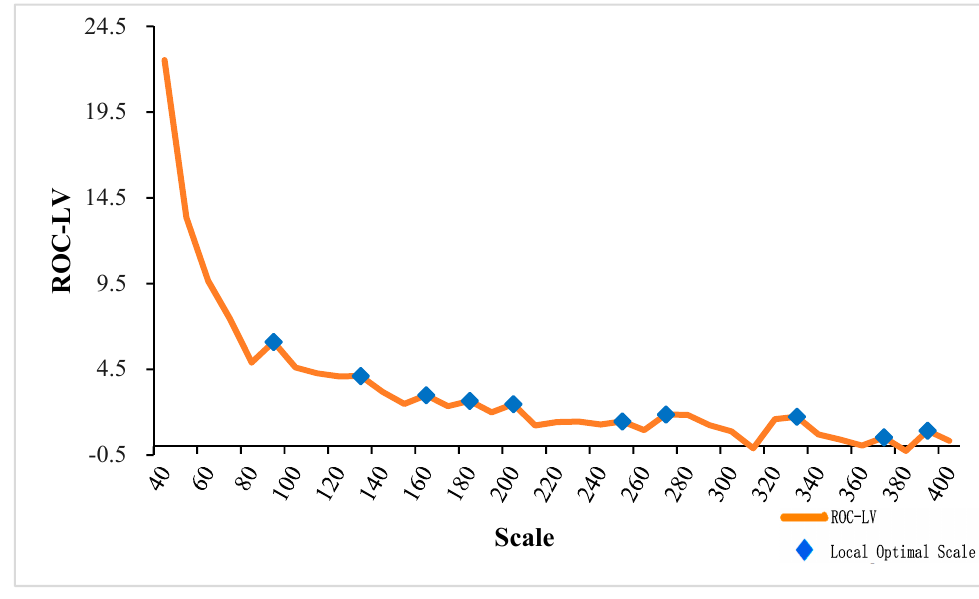
Figure 4. Evaluation of segmentation scale.